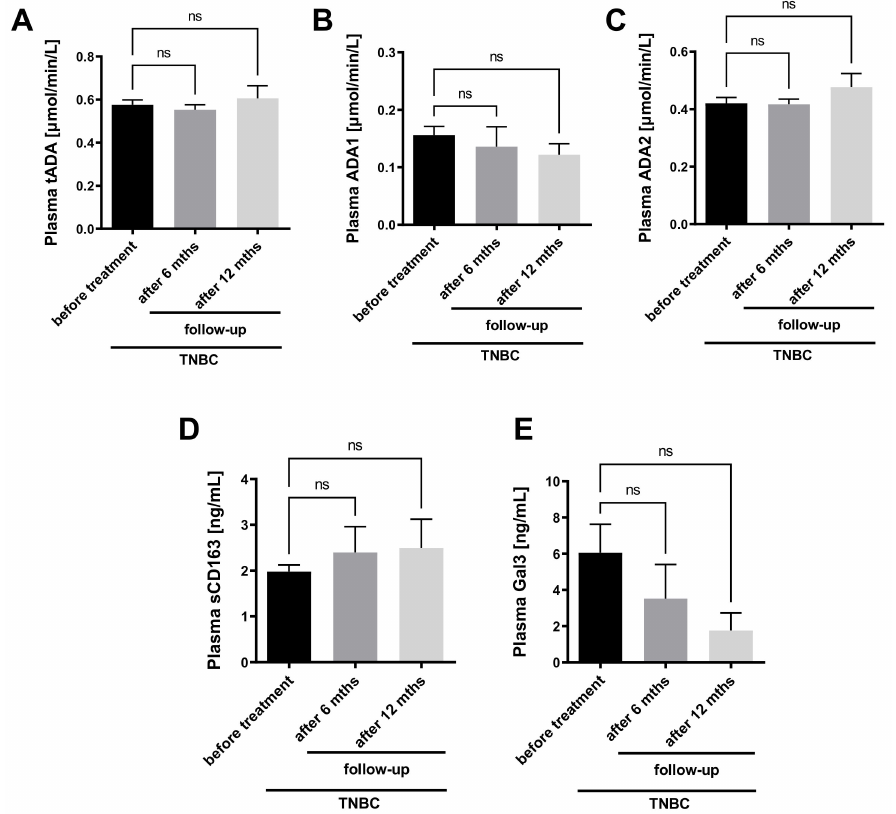
Figure 7. Plasma adenosine deaminase activity and macrophage polarization markers in TNBC patients before and after cancer treatment. The activity of plasma total ADA (tADA, A ), ADA1 ( B ), ADA2 ( C ), and concentration of plasma soluble CD163 (sCD163, D ) and galectin-3 (Gal3, E ) in triple negative breast cancer (TNBC) patients before ( n = 19), 6-months (6 mths, n = 6) and 12- months (12 mths, n = 4) after surgical intervention followed by chemotherapy. Results are shown as mean ± SEM and analyzed by Kruskal-Wallis test followed by Dunn’s post hoc test ( A , B , E ) and one-way ANOVA followed by Holm-Sidak post hoc test ( C , D